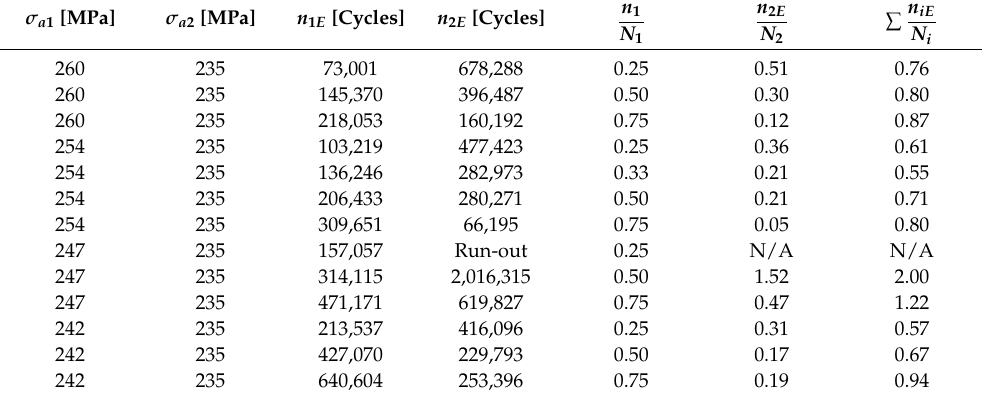
Table A3. Experimental results H–L block loading, specimens extracted from the transverse